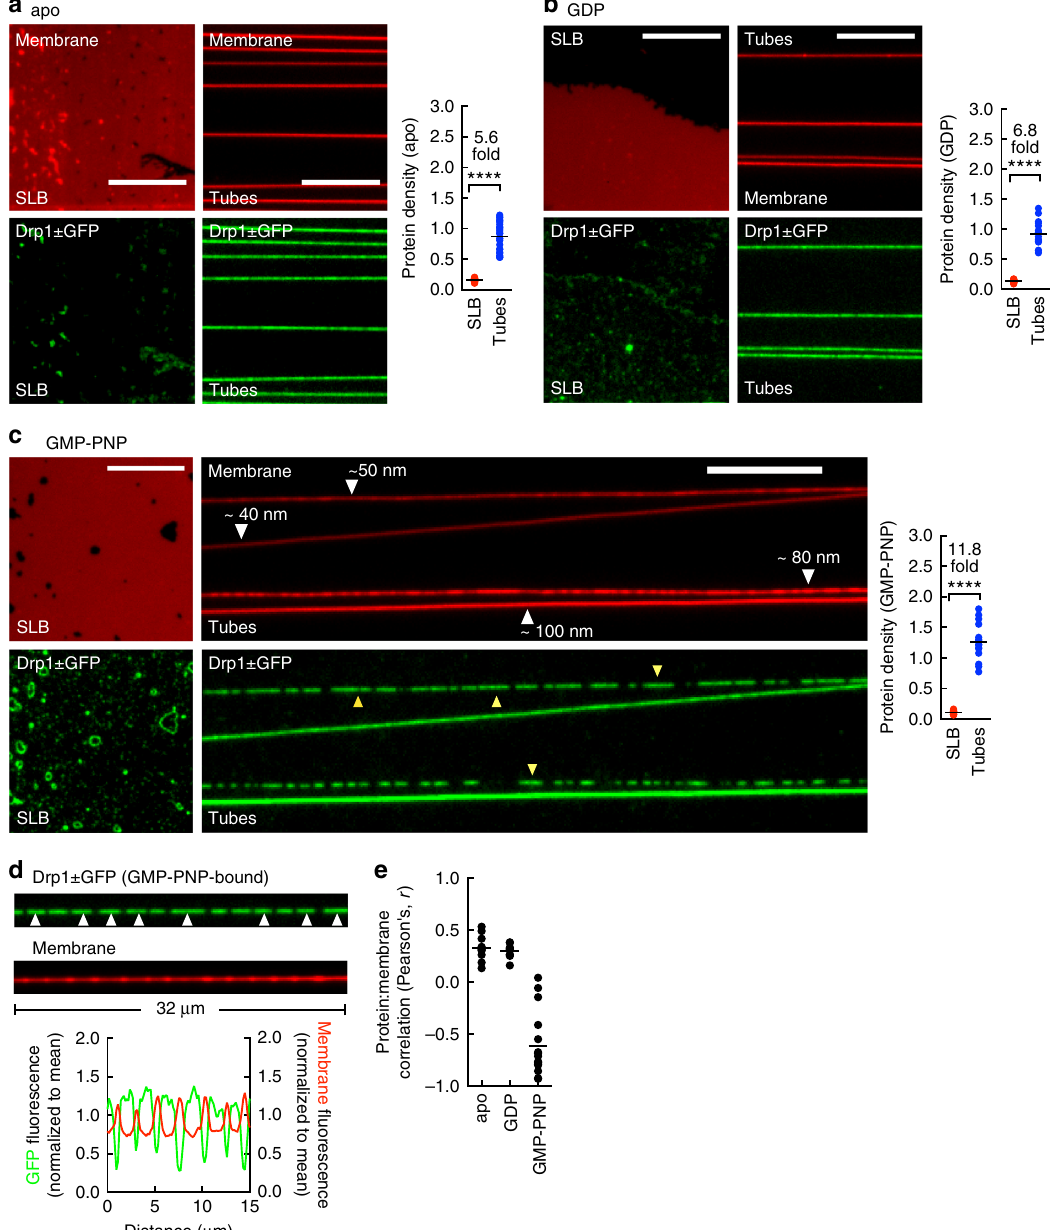
Fig. 5 Self-assembly of Drp1. a Representative images of Drp1 ± GFP on the SLB and tubes in the apo ( a ), GDP-bound ( b ), and GMP-PNP-bound ( c ) states. Scale bar = 10 µ m. Also shown are ratios of Drp1 ± GFP to membrane fl uorescence on the SLB and tubes; **** p < 0.0001, Mann – Whitney test. n (SLB) = 28 and n (tube) = 25 from a single experiment for apo. n (SLB) = 21 and n (tube) = 16 from a single experiment for GDP. n (SLB) = 21 and n (tube) = 15 from a single experiment for GMP-PNP. Yellow arrowheads mark clusters of Drp1 ± GFP on tubes in the GMP-PNP-bound state. d Representative images and associated line pro fi les showing distribution of Drp1 ± GFP with GMP-PNP. White arrowheads mark clusters of Drp1 ± GFP. e Pearson ’ s coef fi cient of correlation between Drp1 ± GFP and membrane fl uorescence. n (apo) = 10, n (GDP) = 10, and n (GMP-PNP) = 16 tubes from a single